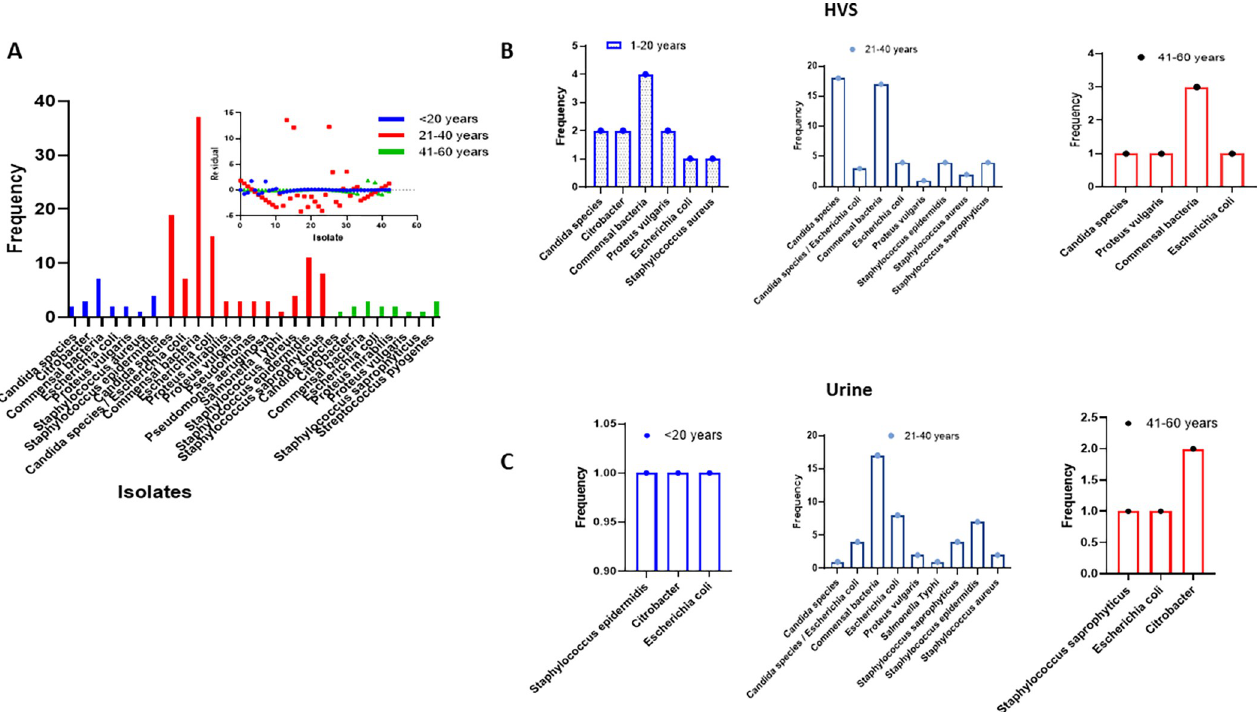
Fig 1. An increased urogenital antibiotic-resistant Escherichia coli infection among females between the ages 21–40 years old. A. The trends in the bacteria isolate among female patients with age categories � 20 years, 21–40 years and 41–60 years. The residual plot analysis showed changes in the trends of bacteria isolates among the age 21–40 years. B. The frequency of bacteria isolates from different specimen types across the age categories � 20 years, 21–40 years and 41–60 years. C. The interleaved bars showing frequencies of bacteria isolates from high vagina swabs (HVS) samples across the age � 20 years, 21–40 years and 41–60